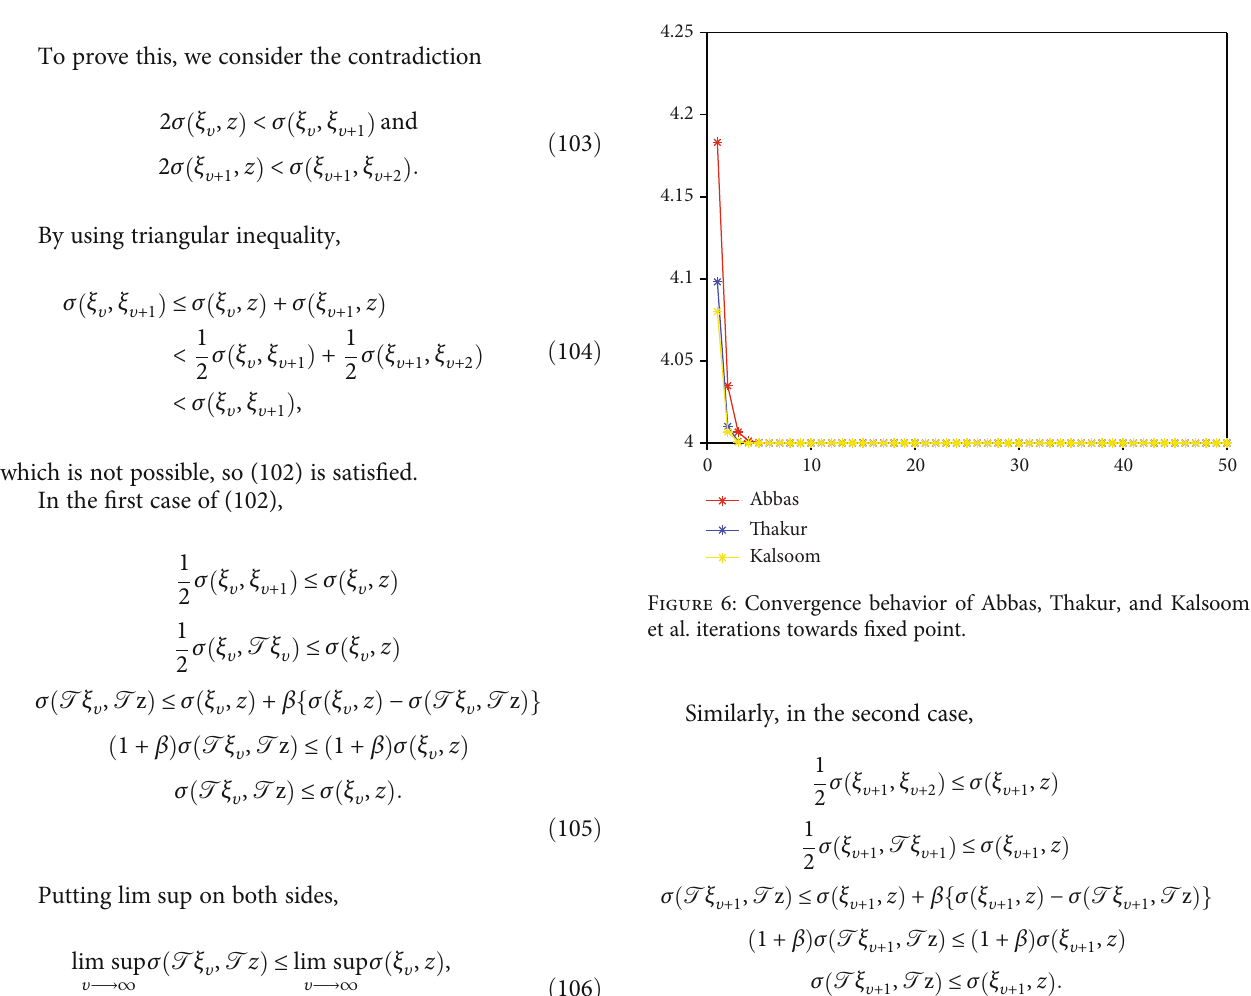
Figure 4: Convergence behavior of Mann, Ishikawa, and Kalsoom et al. iterations towards fi xed point.